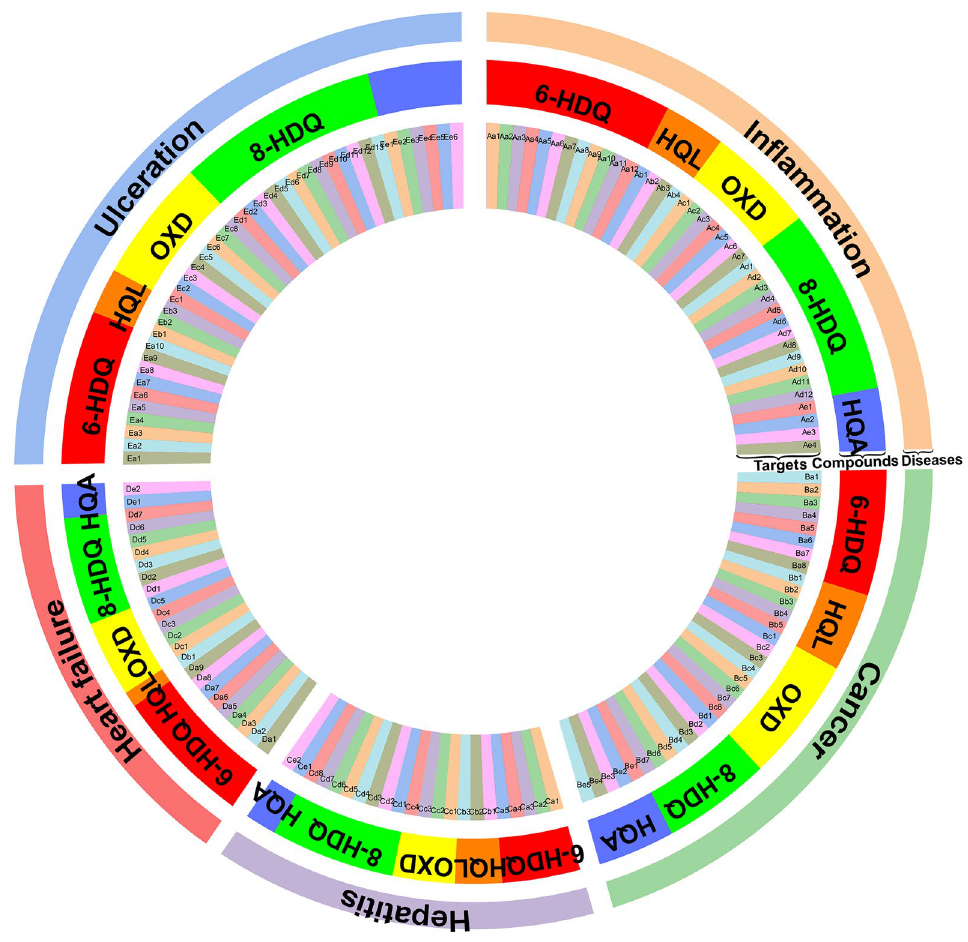
Figure 3. The relationships among P. americana -treated diseases (ulceration, heart failure, hepatitis, cancer, and inflammation, shown by the outer ring of doughnut chart), NCMs (6-HDQ, HQL, OXD, 8-HDQ, and HQA, shown by the center ring of doughnut chart) and their intersecting targets (Aa1 to Ee6, shown by the inner ring of doughnut